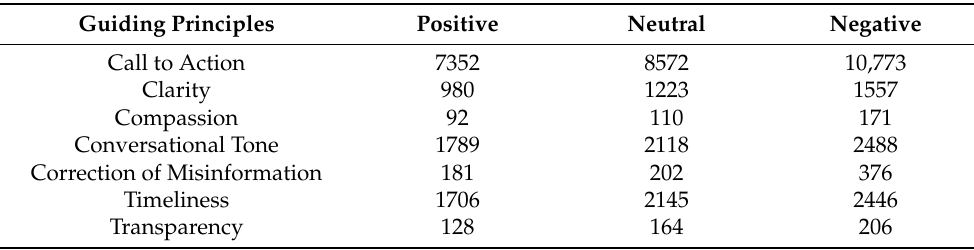
Table 7. Summary of Facebook comment sentiment for Healthy Canadians, CBC News, and CTV News combined by guiding